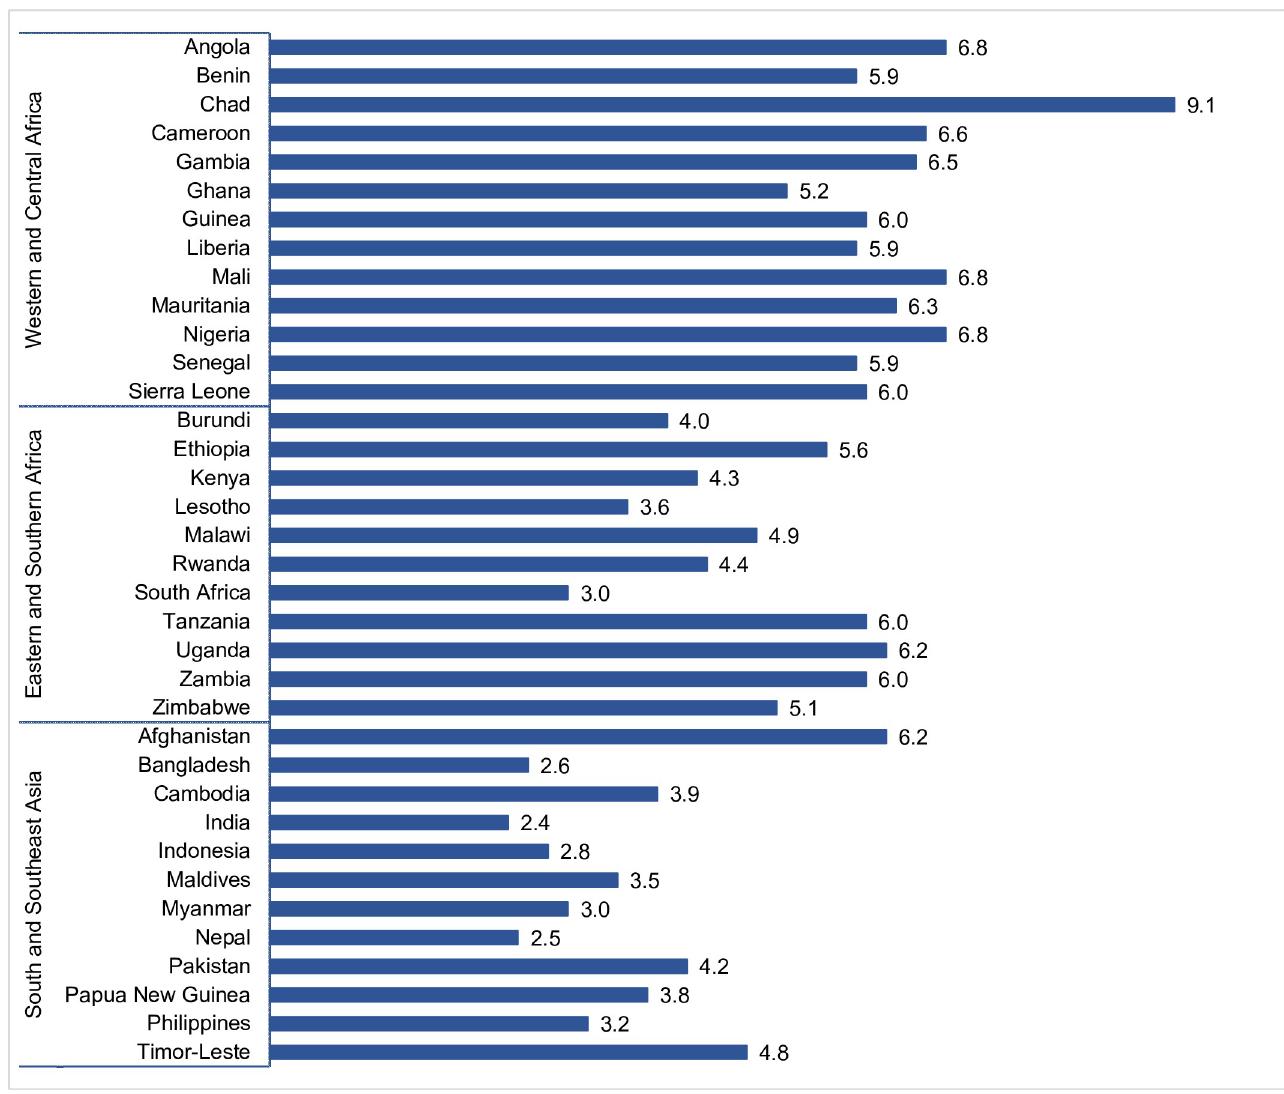
Fig 1. Mean ideal number of children among women age 44–48.